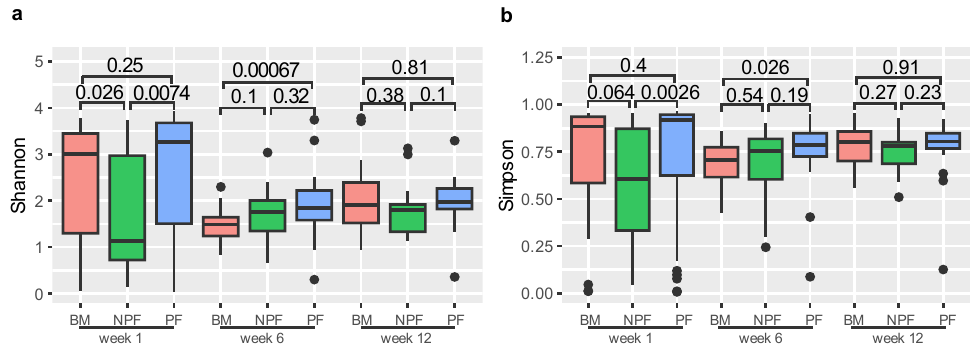
Figure 1. Alpha diversity of each group at three time points, measured by Shannon ( a ) and Simpson ( b ) indices. BM, breastmilk; PF, probiotics formula; NPF, non-probiotics formula. ( b ) indices. BM, breastmilk; PF, probiotics formula; NPF, non-probiotics